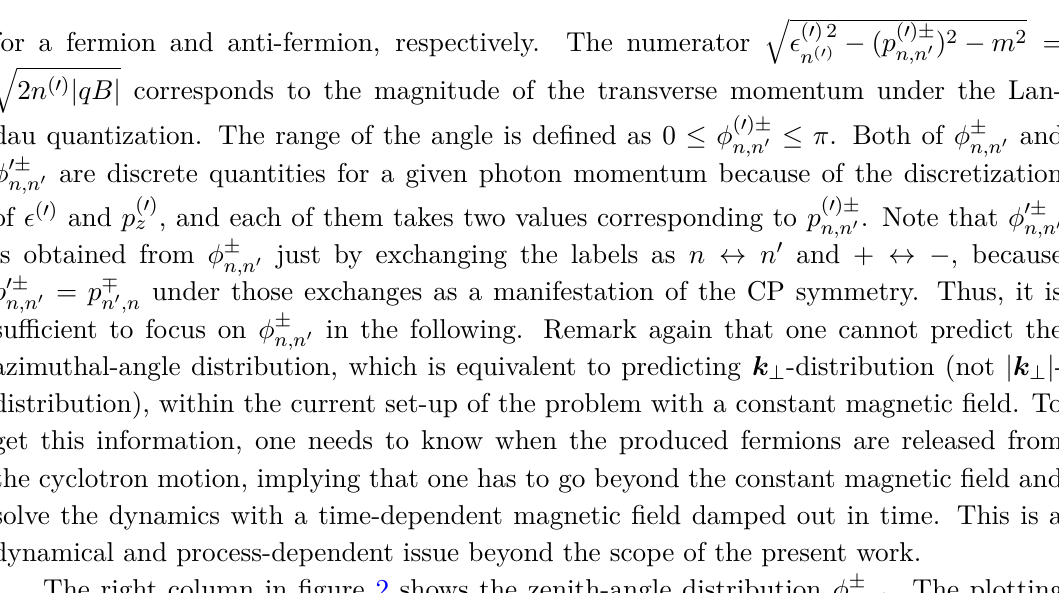
Figure 3 . A schematic picture of the on-shell fermion momentum p ± zenith angle φ ± for a vanishing photon longitudinal momentum k n,n 0 by a nonzero k 0 (right). Shown is the case for n = n 0 where the two cones appear in the same z > size at k = 0 z